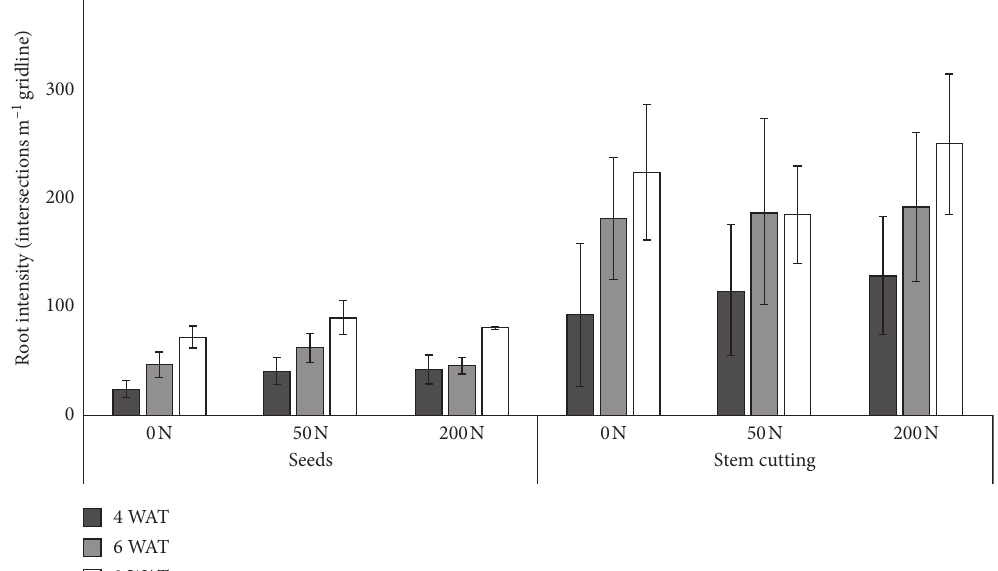
Figure 7: Root intensity (intersections m − 1 gridline) of E. pellita seedlings from seeds and stem cutting at different N concentrations (0, 50, and 200 kg N ha − 1 ) at three selected dates of root measurement (4, 6, and 8 weeks after transplanting, WAT). The mean values were tested using ANOVA followed by Tukey HSD’s post hoc Test. The mean values were not significantly different between the different N concentrations for each date ( P > 0 . 05). Bars represent standard deviations of the mean, n � 12 (4 WAT), n � 8 (6 WAT), and n � 4 (8 WAT).